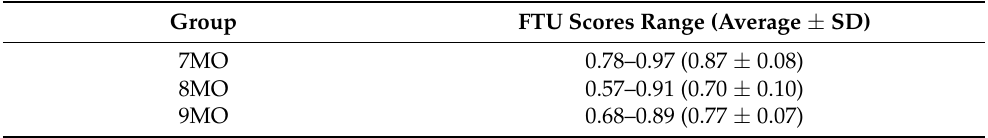
Figure 4. LEfSe identified the differentially abundant metabolic pathways among sampling time. The histogram shows the linear discriminant analysis (LDA) scores in different colors, according to age group. Table 2. The Fraction Taxonomic Units Unexplained (FTU) scores of Tax4Fun metagenome prediction for Seriolella violacea microbiota, according to sampling